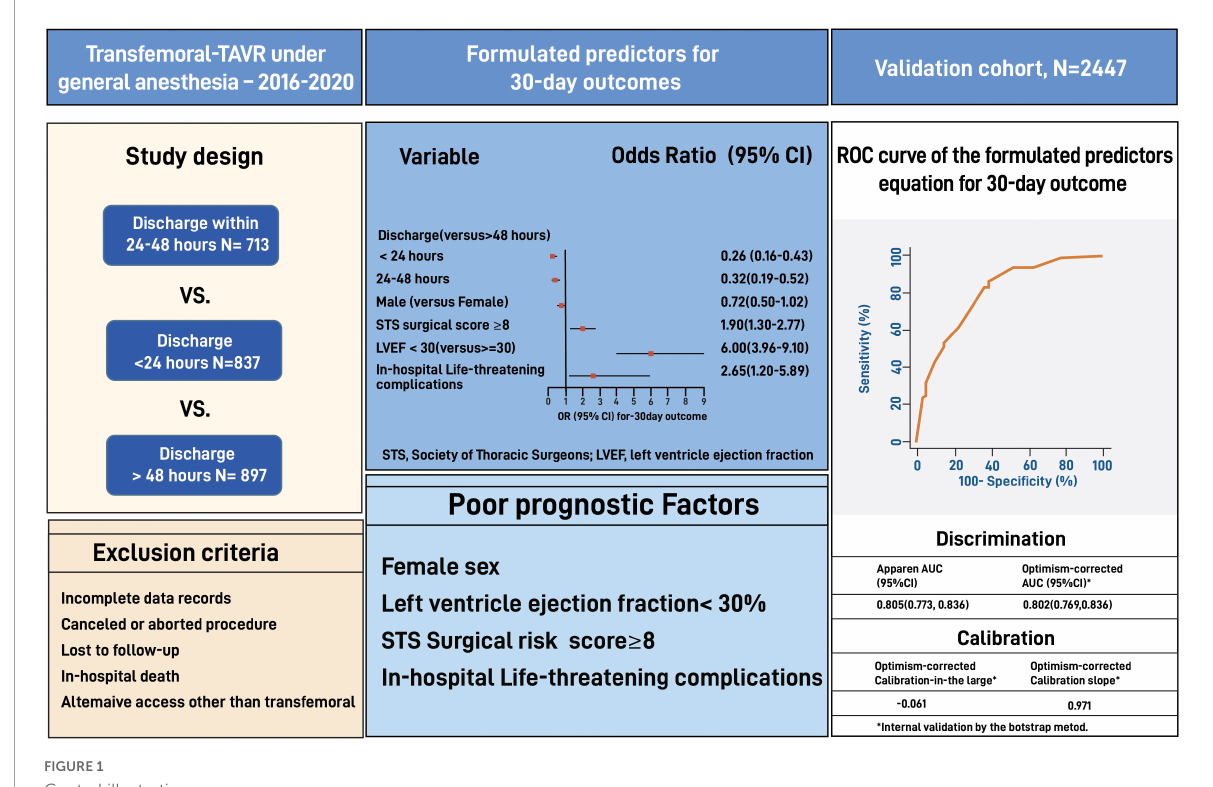
FIGURE1 Central illustration.